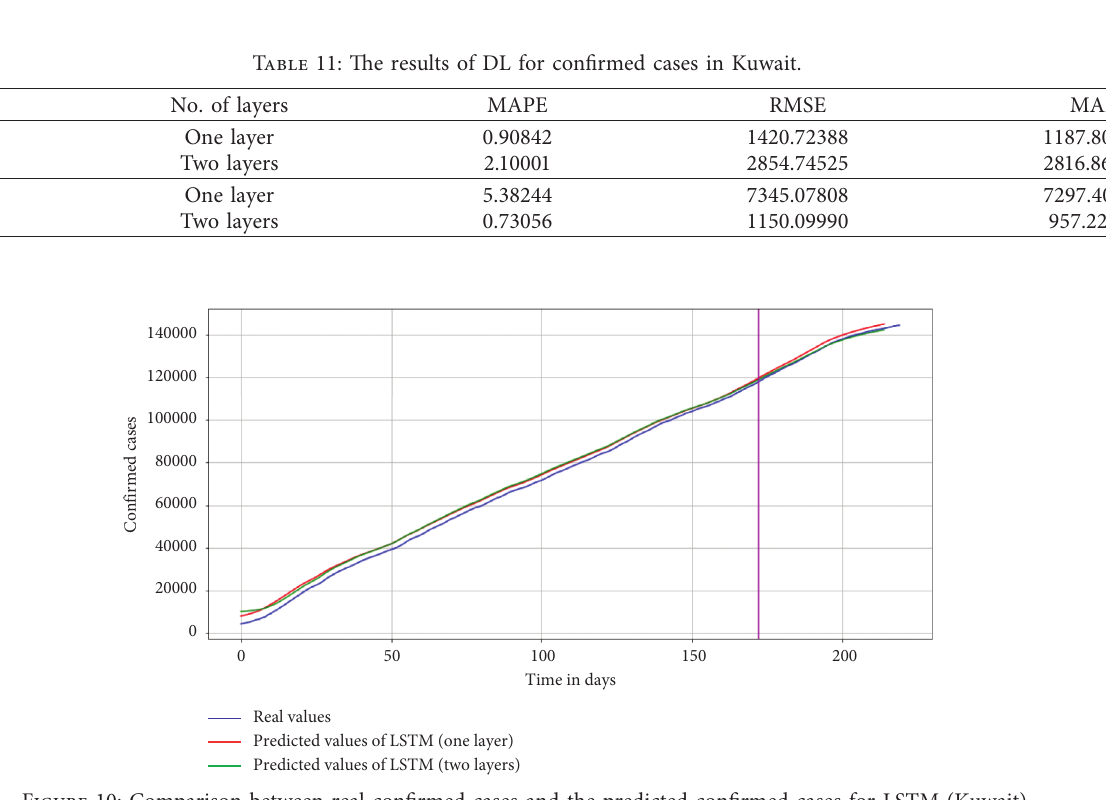
Figure 10: Comparison between real confirmed cases and the predicted confirmed cases for LSTM (Kuwait).